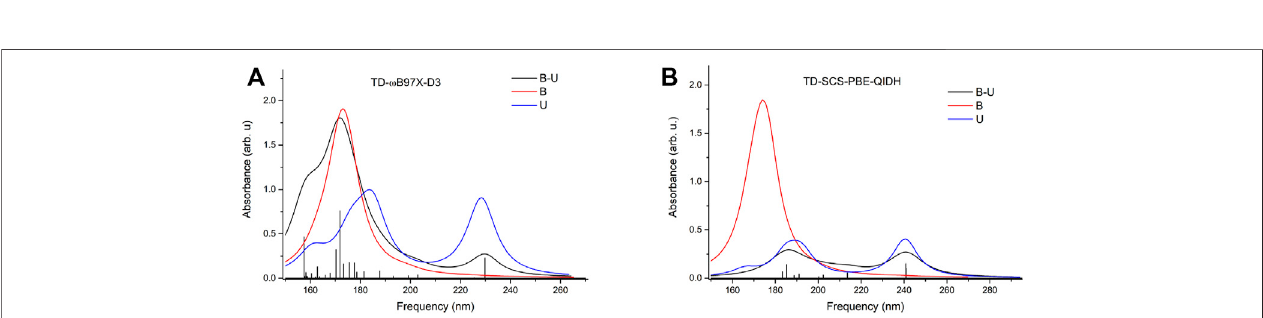
Frontiers in Bioengineering and Biotechnology |